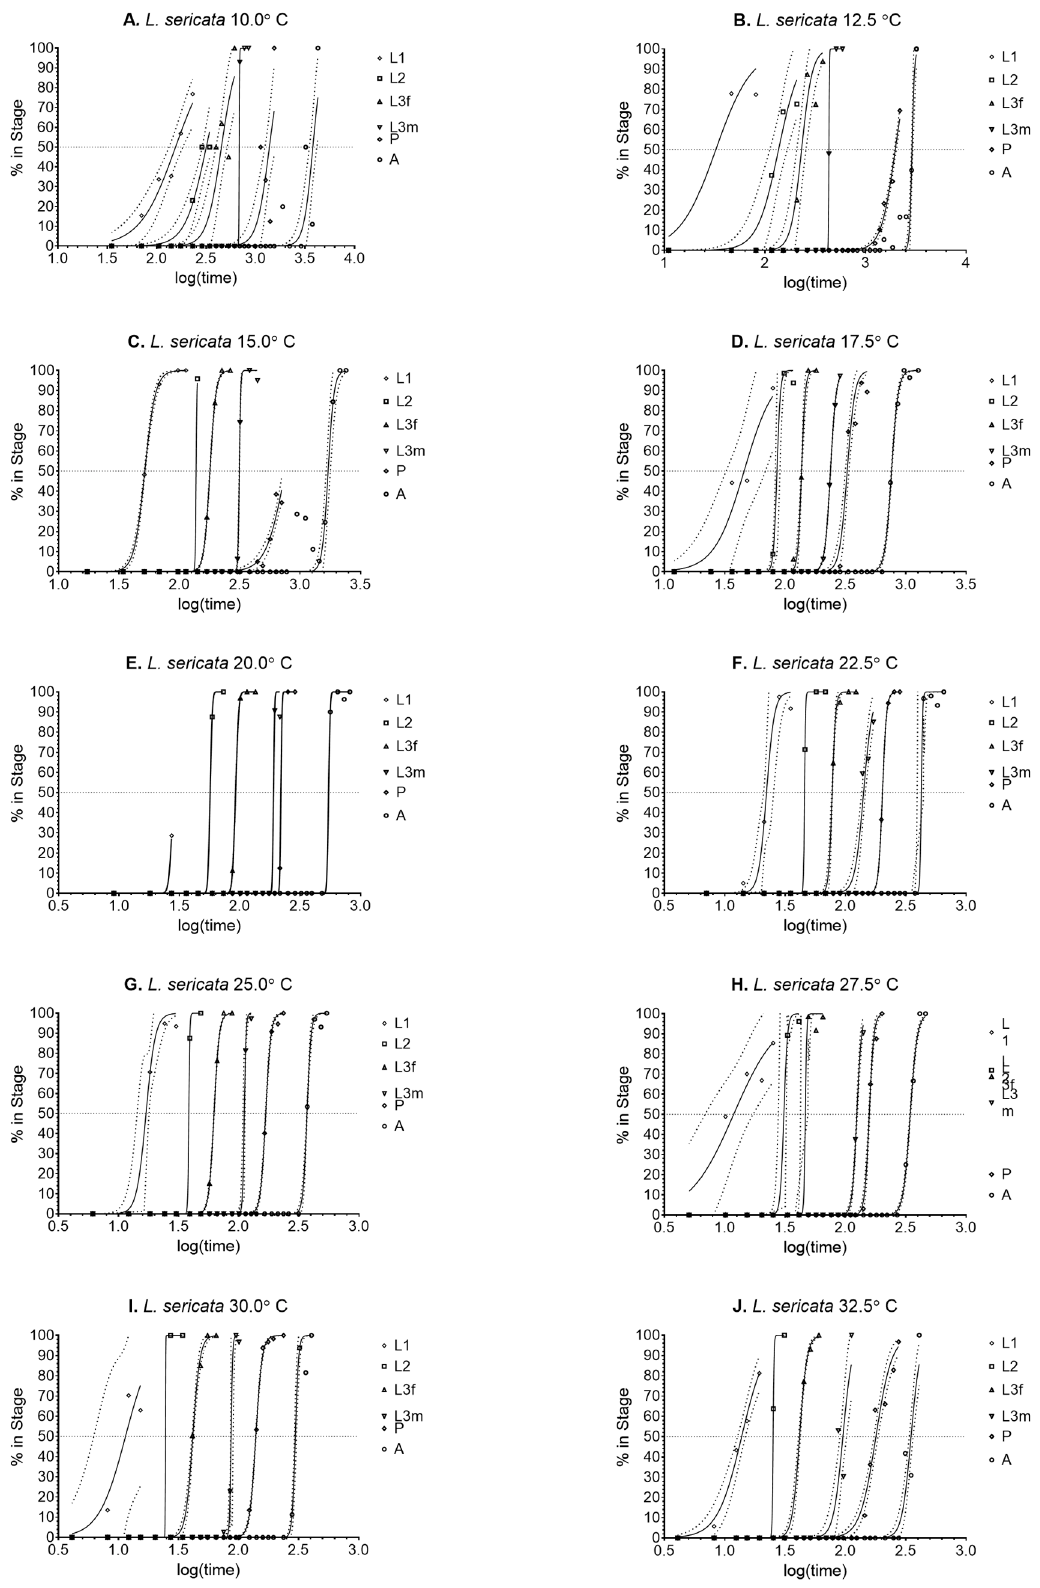
Figure 2. Probit analysis curves used to determine 50% of the transition population for Lucilia sericata at 10.0–32.5 °C (Figure 2A–J, respectively). Confidence intervals are represented by dotted lines.